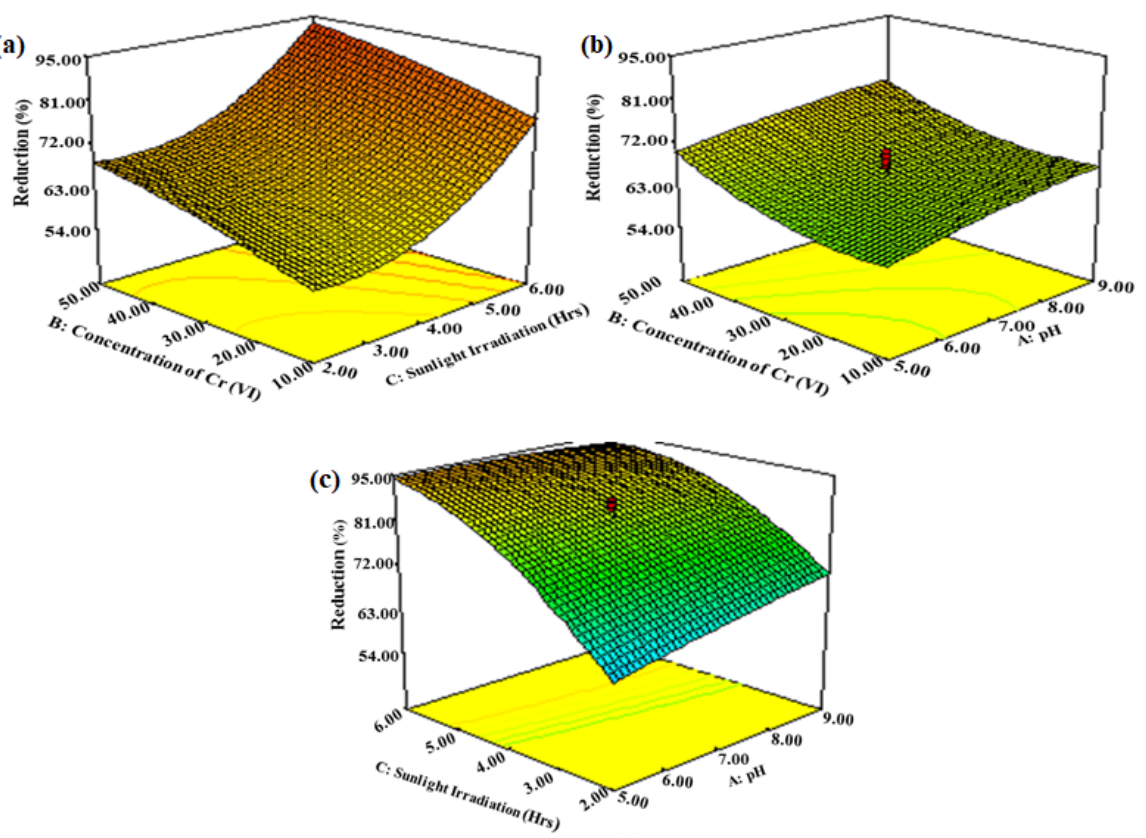
Figure 6. ( a ) RSM 3D interactive plot of irradiation time and initial concentration of Cr(VI), ( b ) interactive plot of pH and initial concentration of Cr(VI), and ( c ) interactive effect of irradiation time and pH.